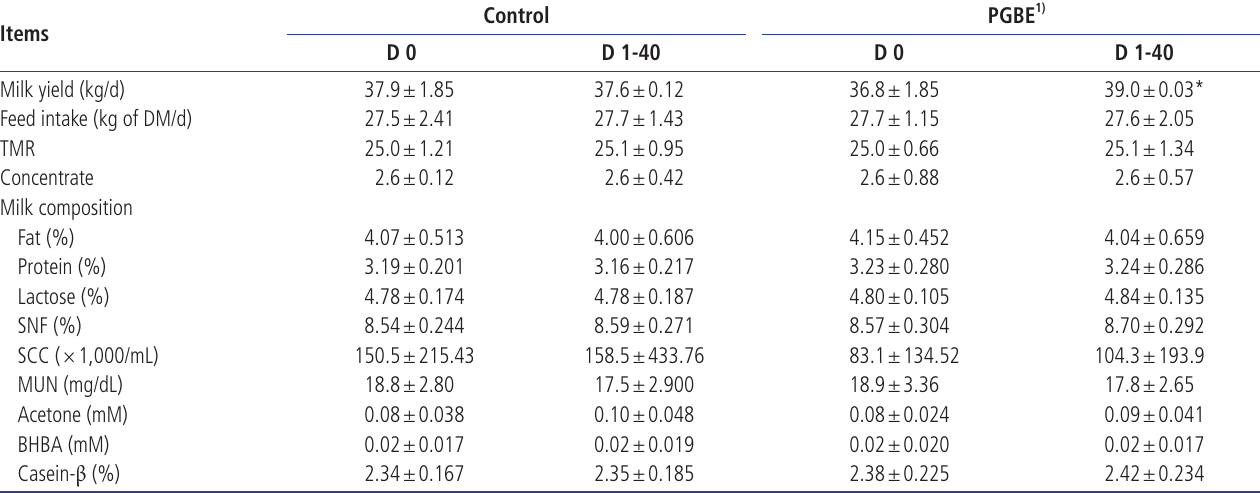
Values represent the means plus standard deviation of 20 individual dairy cows. PGBE, a mixture of pinecone oil, garlic kernel, and brown seaweed midrib extracts; TMR, total mixed ration; SNF, solids-not fat; SCC, somatic cell count; MUN, milk urea nitro-